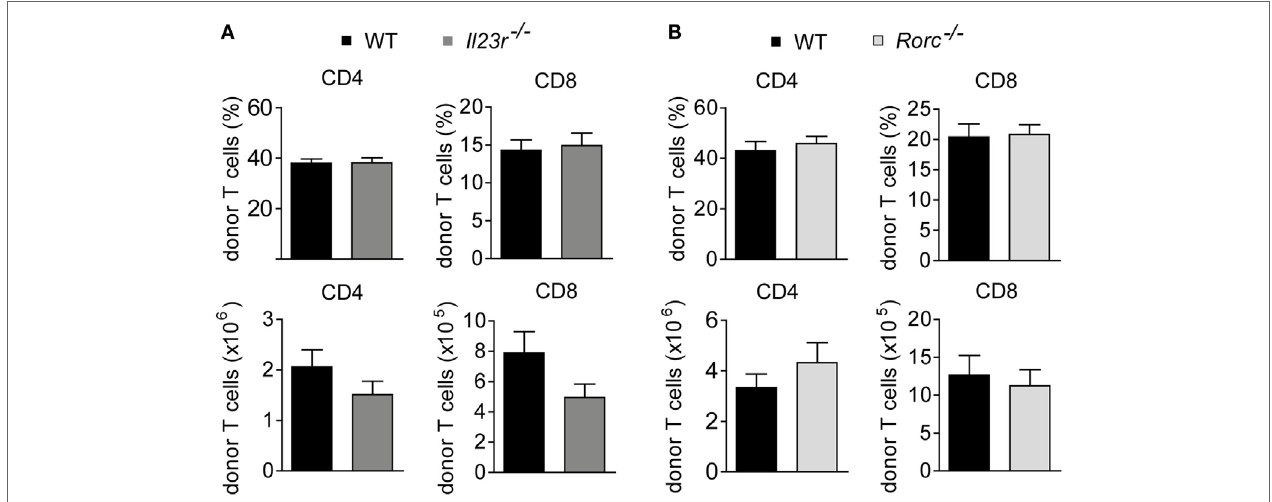
FigUre 3 | Colonic donor T cell expansion occurs in an interleukin-23 receptor (IL-23R)- and retinoic acid-related orphan receptor gamma t-independent manner. At day 28–31, colonic lamina propria mononuclear cells of allogeneic hematopoietic stem cell transplantation BALB/c mice with fully established clinical signs of intestinal graft-versus-host disease due to the transfer of allogeneic T cells derived from wild-type (WT) ( n = 14) and Il23r − / − ( n = 15) mice (a) or WT ( n = 12) and Rorc − / − ( n = 11) mice (B) were analyzed by flow cytometry. The frequency and absolute number of CD4 + and CD8 + donor T cells are displayed. Data represent pooled results from two independent experiments and were analyzed by Student’s t -test. Data display mean ±